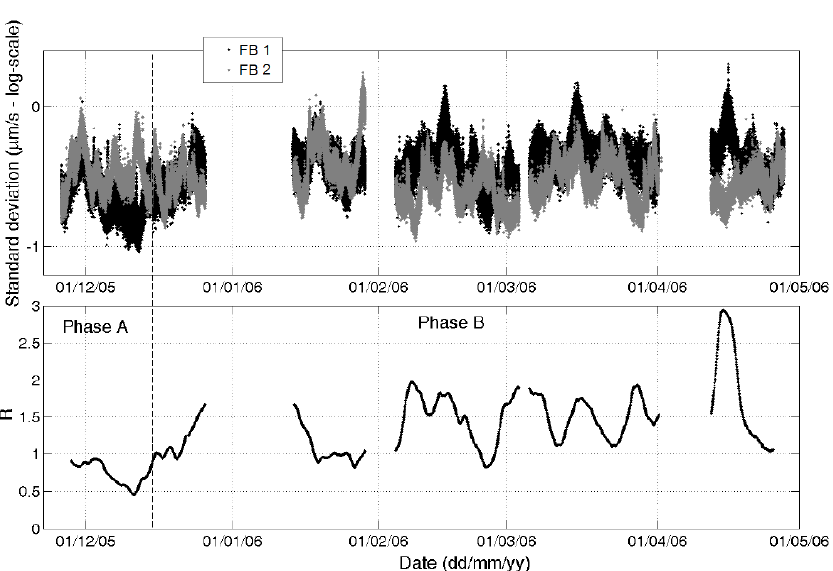
Fig. 4. (a) Time-evolution of the standard deviations of the two FBs estimated within time-windows of 60s and averaged over the three ground motion components. The curves are plotted in log-scale and transient seismic events are discarded from the analysis. (b) Ratio between the standard deviation of FB1 and FB2 averaged over 4 days to get a smoothed curve. We define as Phase A the time-interval 25/11/2005–15/12/2005 in which this ratio is mostly lower than one, whereas in the rest of the data set (Phase B) there is a predominance of higher